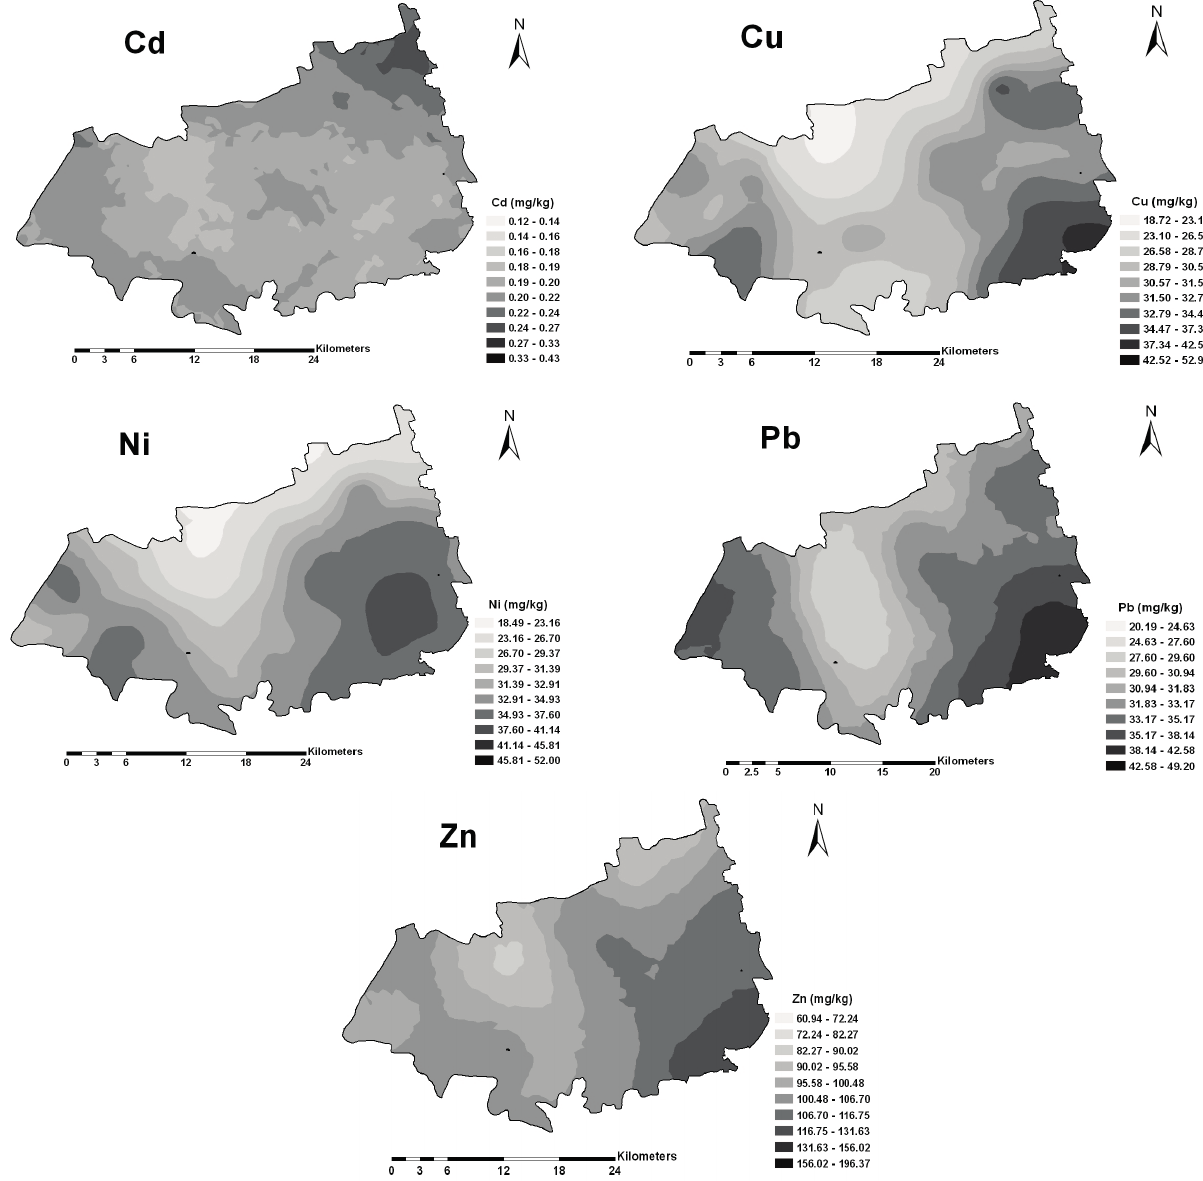
Figure 3. Spatial distribution maps of heavy metals in